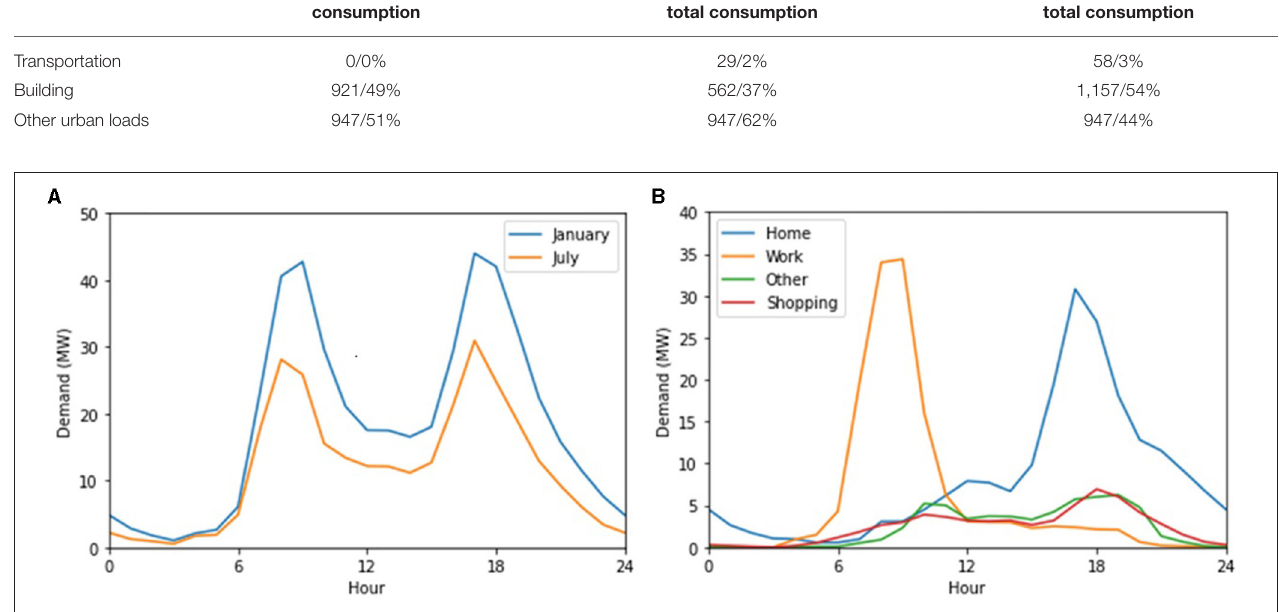
FIGURE 9 | (A) EV charging demand load at 50% EV penetration compared seasonally (left) and (B) winter EV charging demand load for 50% EV penetration disaggregated by trip activity